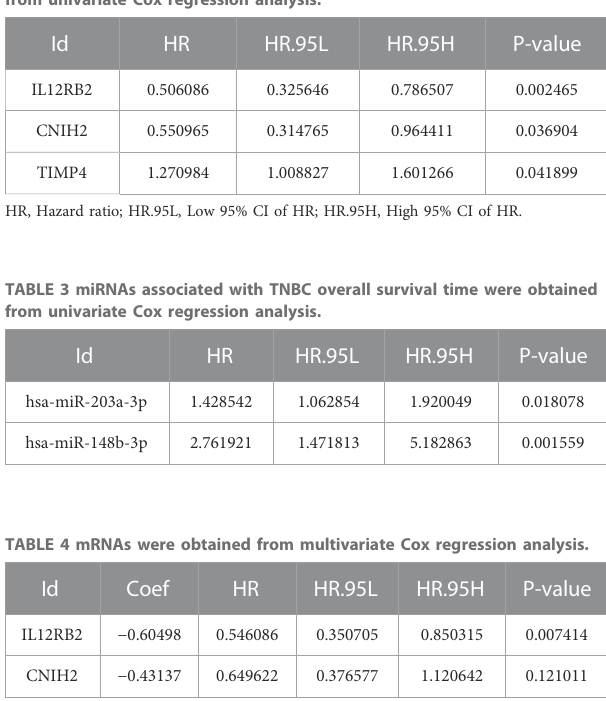
TABLE 2 mRNAs associated with TNBC overall survival time were obtained from univariate Cox regression analysis.